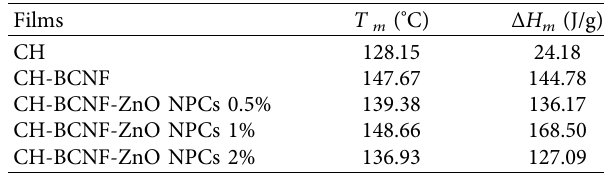
Table 2: Termal properties of the flms.